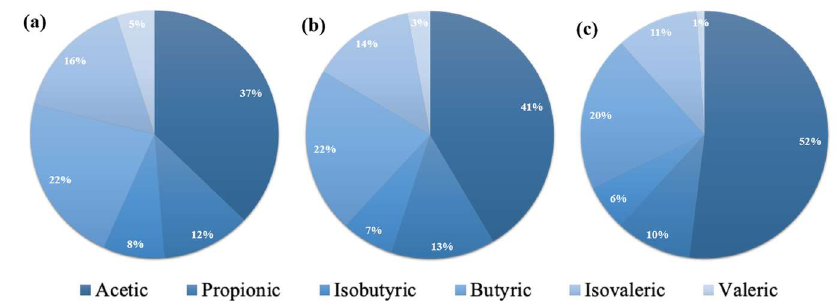
Figure 5. Composition in terms of the COD SOL percentage of the SCFAs obtained from the mesophilic batch series M8 ( a ), M12 ( b ), and M8-P ( c ) as the average of all the initial pH.